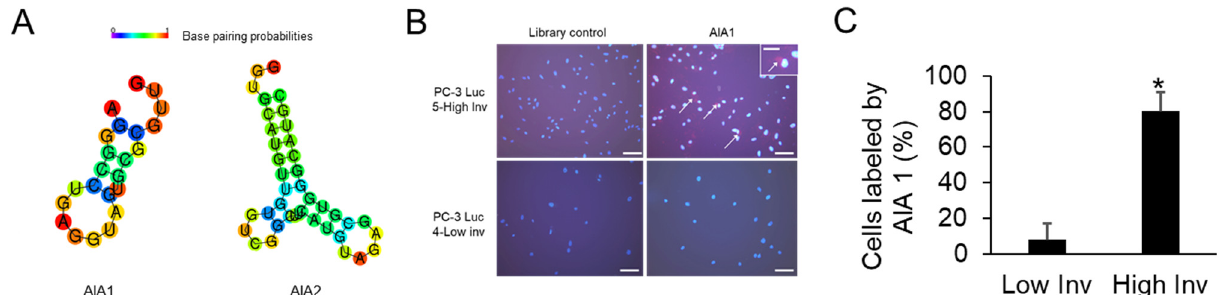
Figure 3. Binding of aptamer A1A1 to invasive and non-invasive PC-3 Luc cells. High invasive and low invasive cells were incubated with fluorescently labeled aptamer A1A1 or RNA pool that had not been subject to SELEX procedure. ( A ) Predicted secondary structures of anti-invasive aptamers. ( B ) Fluorescent images of cells incubated with aptamers. The red color indicates the presence of bound RNA. Arrow, Aptamer bound to surface of a cell. Inset, Cell with bound aptamer. Bar in main figures = 50 μ m; bar in inset = 20 μ m. ( C ) The percent of cells bound by AIA1 were determined in low and high invasive images from two independent samples. Data are shown as mean ± SD. * p < 0.05.